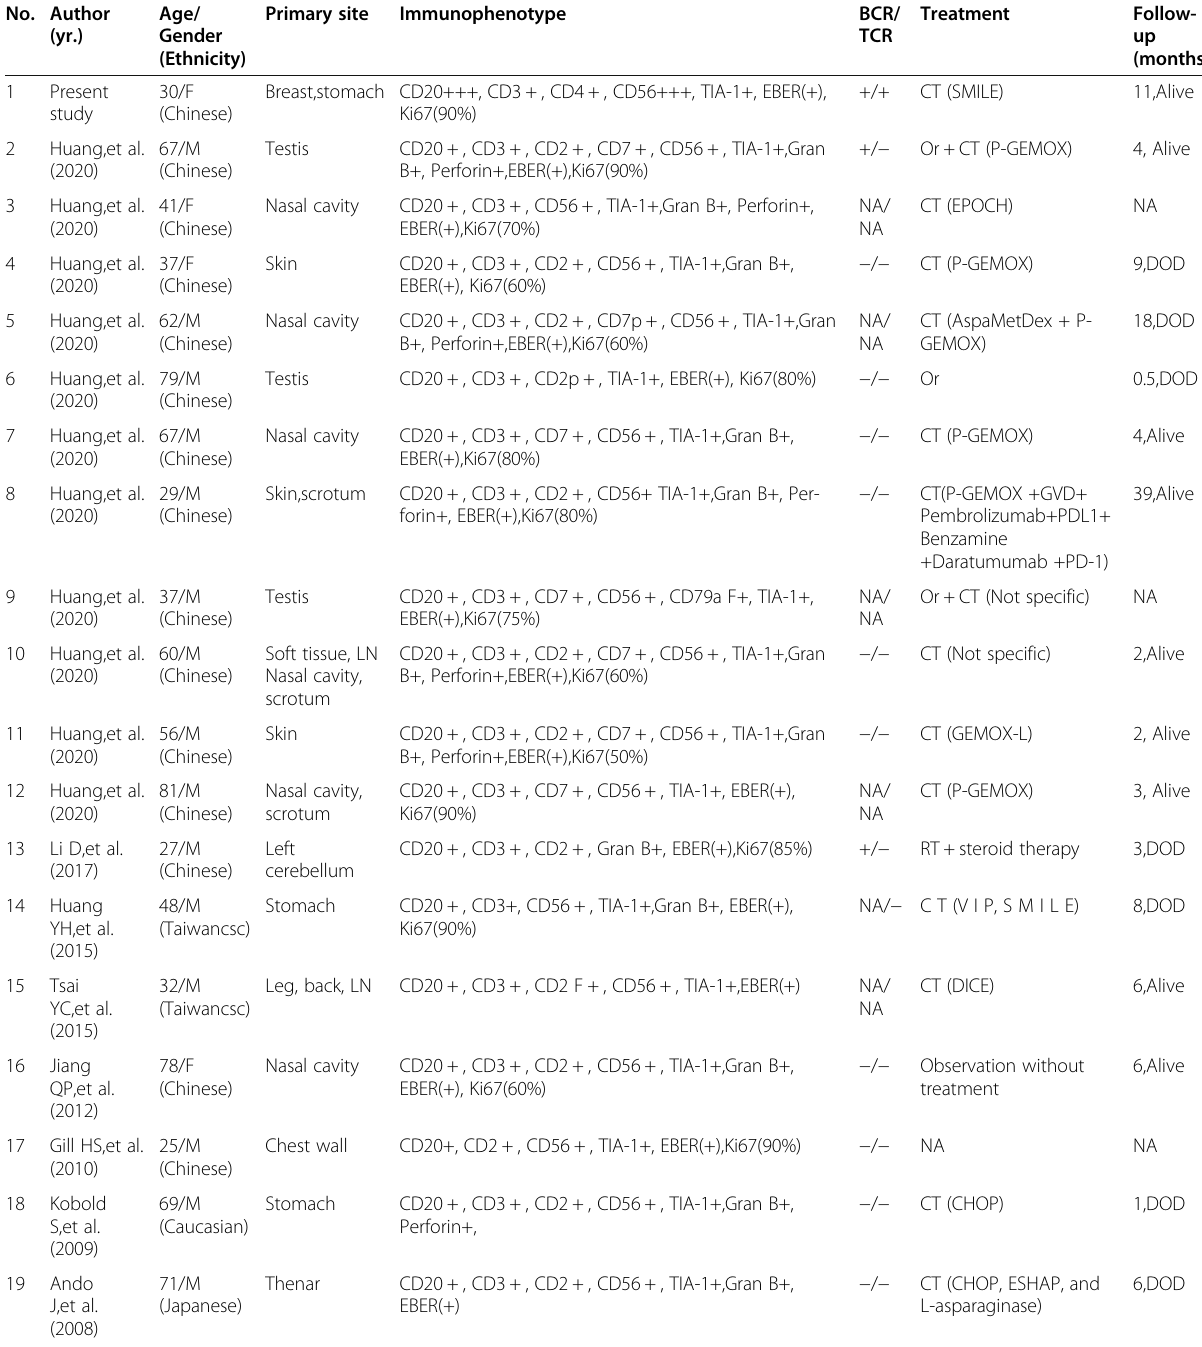
Table 1 Clinicopathologic features of NK/T-cell lymphoma patients with aberrant expression of CD20 in present and previous literature